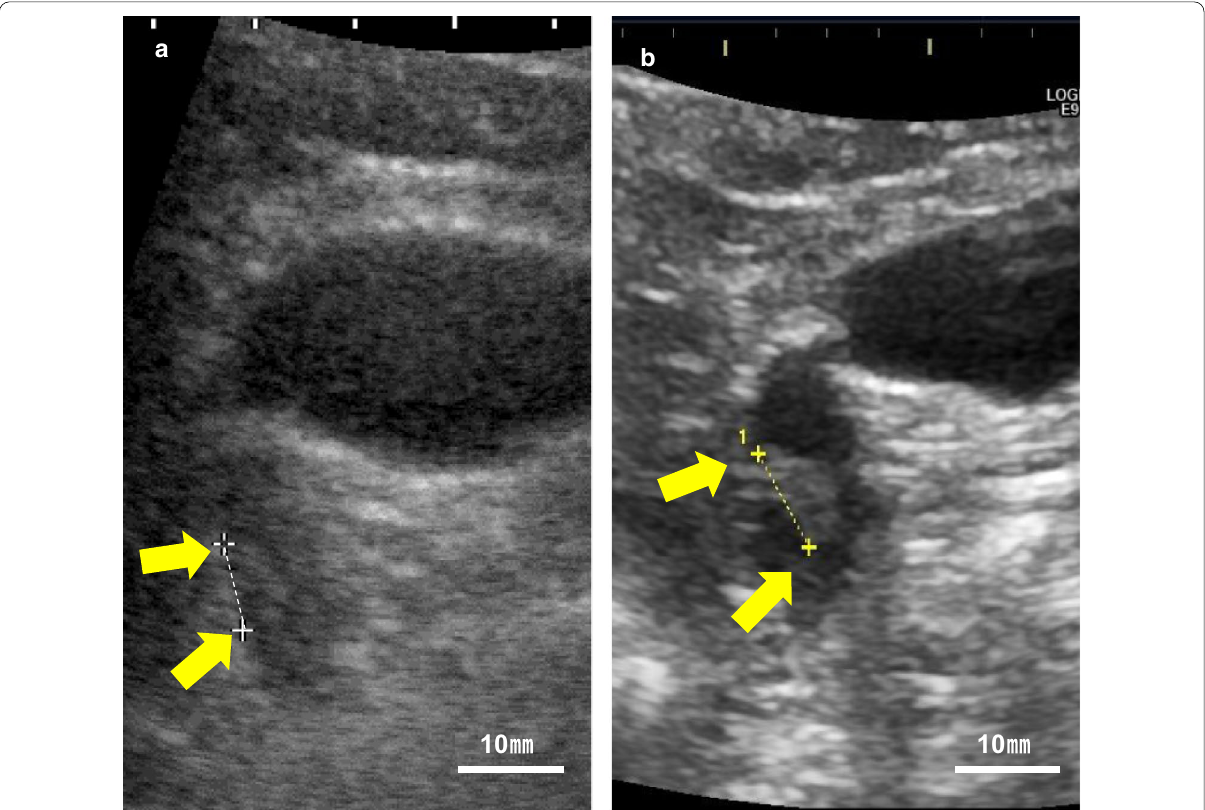
Fig. 1 Ultrasound of the gallbladder showed a well‑defined, smooth mass of mixed hypo‑ and iso‑echogenicity at the gallbladder neck (arrows). a The diameter of the mass was 8.3 mm. b The tumor increased in size to 9.9 mm. Scale bar